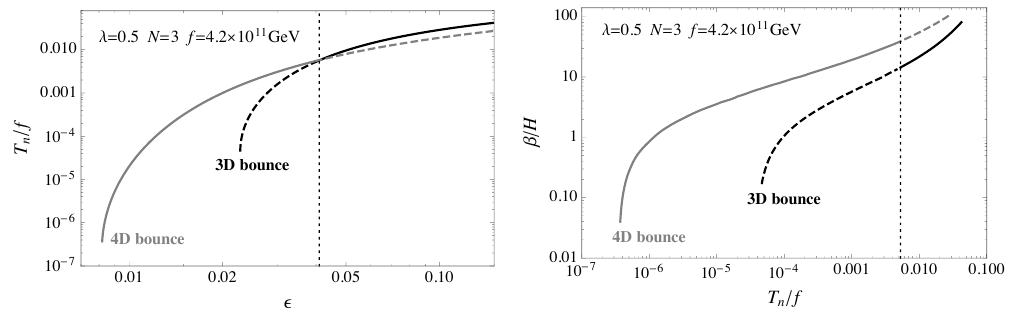
Figure 6 . Parameters of the phase transition in the strongly coupled case. Left: nucleation temperature versus (cid:15) . Right: (cid:12)=H as a function of the nucleation temperature. The normalization of the scale takes into account the factor 4 (cid:25)=N